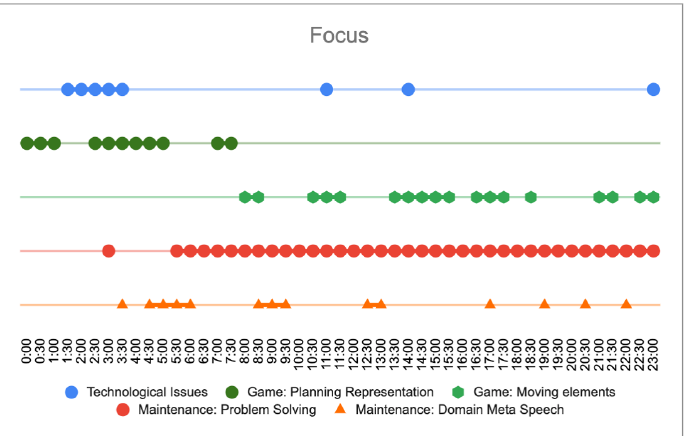
Figure 5. Focus of conversation during Phase